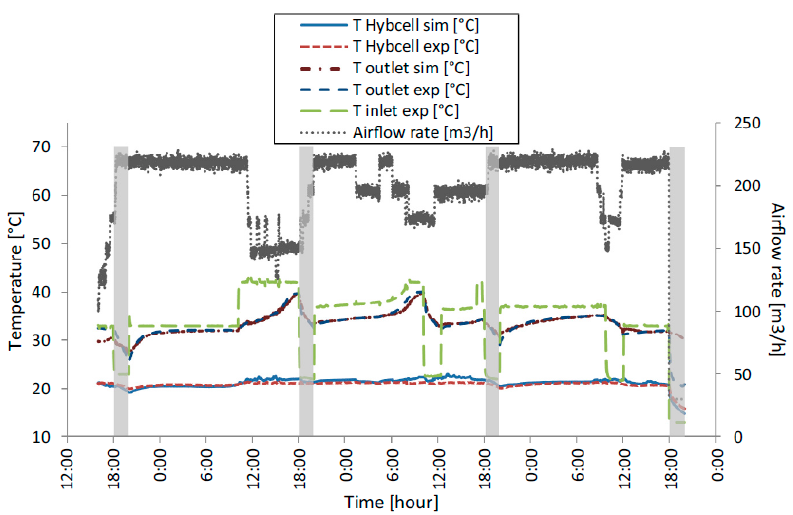
Figure 9. Numerical and experimental results for the PCM storage unit for peak load shifting over four days [101].